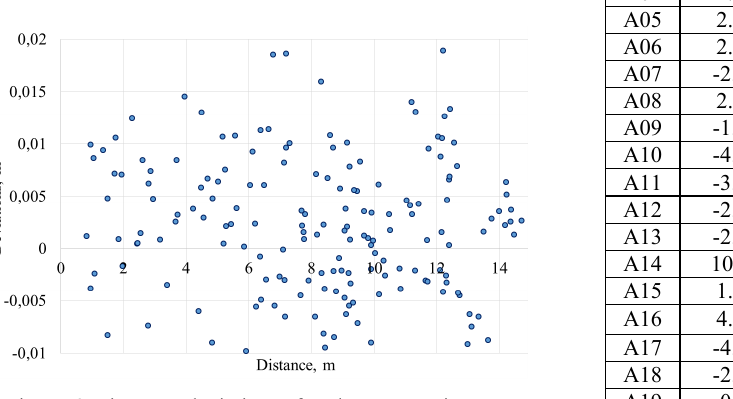
Figure 6. Distances deviations after the systematic error correction